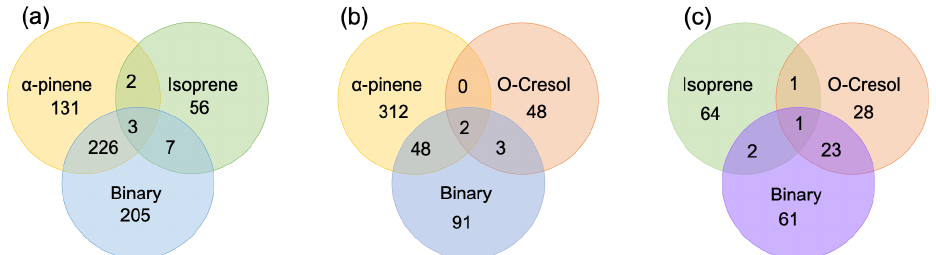
Figure 3. Number of common discrete compounds and unique compounds in single and binary precursor mixed experiments detected by positive-ionization-mode LC-Orbitrap MS. Products are considered identical in mixed and single precursor systems if a compound has the same empirical formula and the retention time difference < 0.1min.